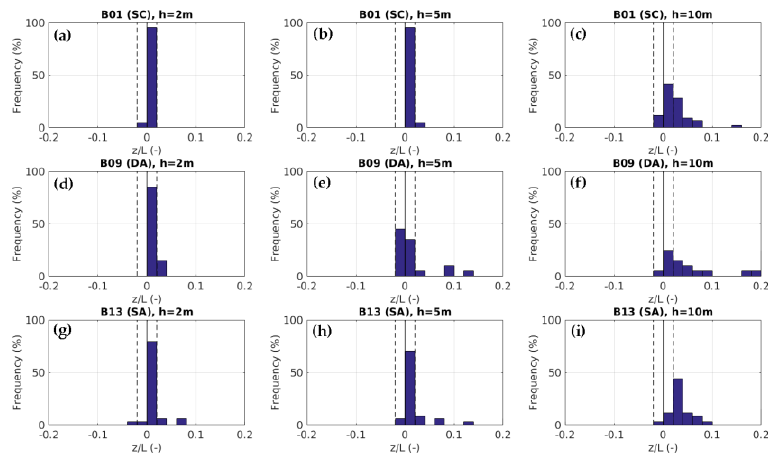
Figure 17. The stability parameter ζ distribution for the B01 ( a – c ), B09 ( d – f ), and B13 ( g – i ) bora episodes at three different vertical levels: 2 m ( a , d , g ), 5 m ( b , e , h ), and 10 m ( c , f , i ).